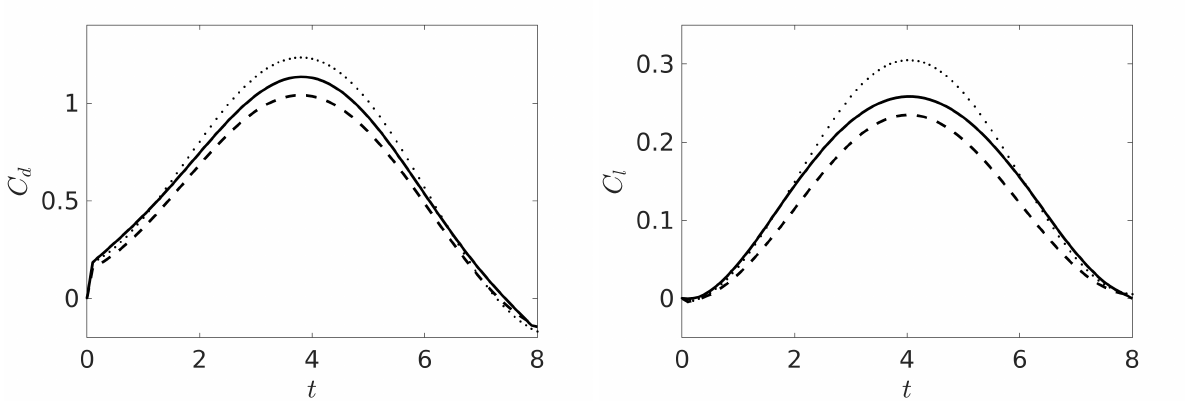
Figure 4. Aerodynamic coefficients C d ( left ) and C l ( right ) computed by FOM (solid line), SUP 2 -ROM (dotted line), and PPE-ROM (dashed